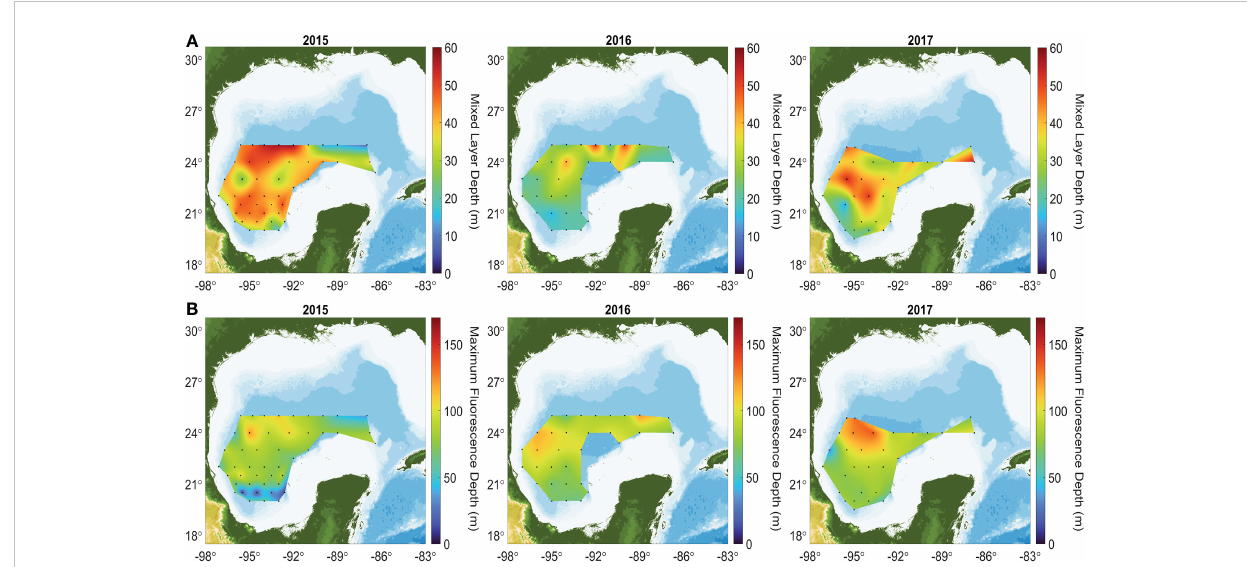
2016 (Figure 4-right panel) with a mean of 35 ± 9 m and with the deepest values toward the center of the GoM.